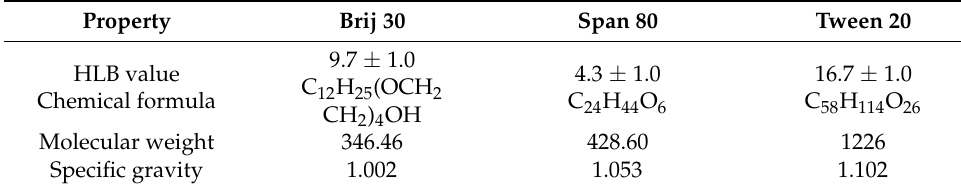
Table 1. Comparison of properties of the surfactants used in this study [26]. Property